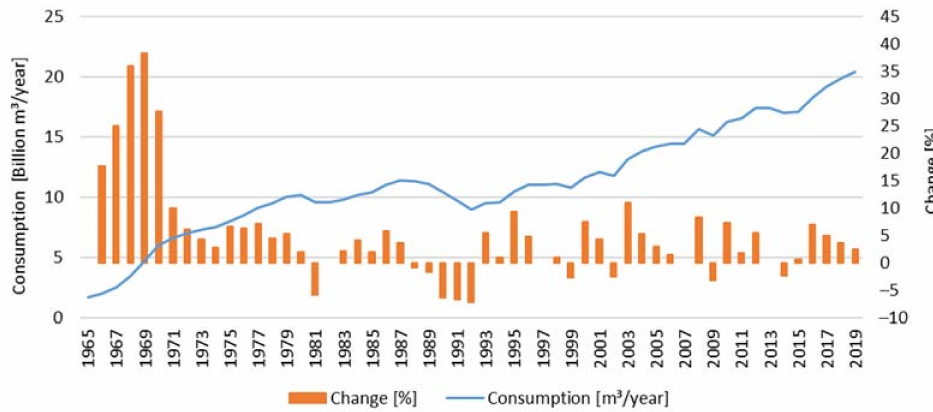
Figure 2. Changes in natural gas consumption in Poland